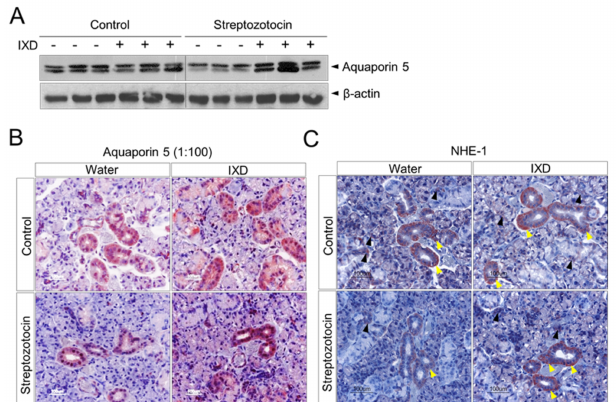
Figure 5. Expression of AQP5 and NHE1 in the submandibular gland. ( A ) Western blot analysis showing AQP5 protein expression in submandibular gland tissue lysates. The blot identified two bands of AQP5 (27 kDa and 31 kDa) revealing non-glycosylated and glycosylated forms of the AQP5 protein respectively; ( B ) the expression of AQP5 (1:100) was performed on submandibular gland tissue sections of either water or IXD extract-treated control or diabetic rats. Brownish red colour indicates the positive expression of AQP5. Magnification: 40 × ; Scale bar: 100 µ m; ( C ) immunohistochemical detection of NHE1 in submandibular gland tissue from normal and diabetic rats treated with water or the IXD extract. Yellow arrow heads show the expression of NHE1 in duct cells, whereas black arrow heads indicate acinar expression. Magnification: 40 × ; Scale bar: 100 µ